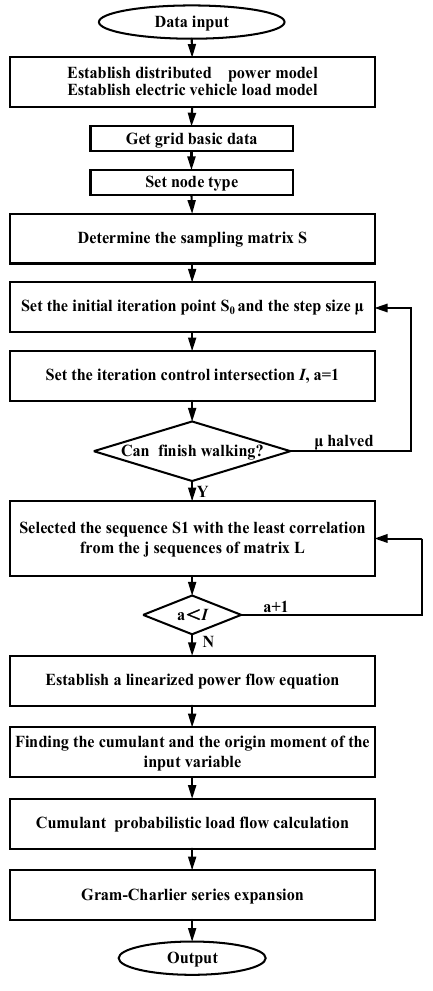
Figure 2. ILHS-CM algorithm flowchart.